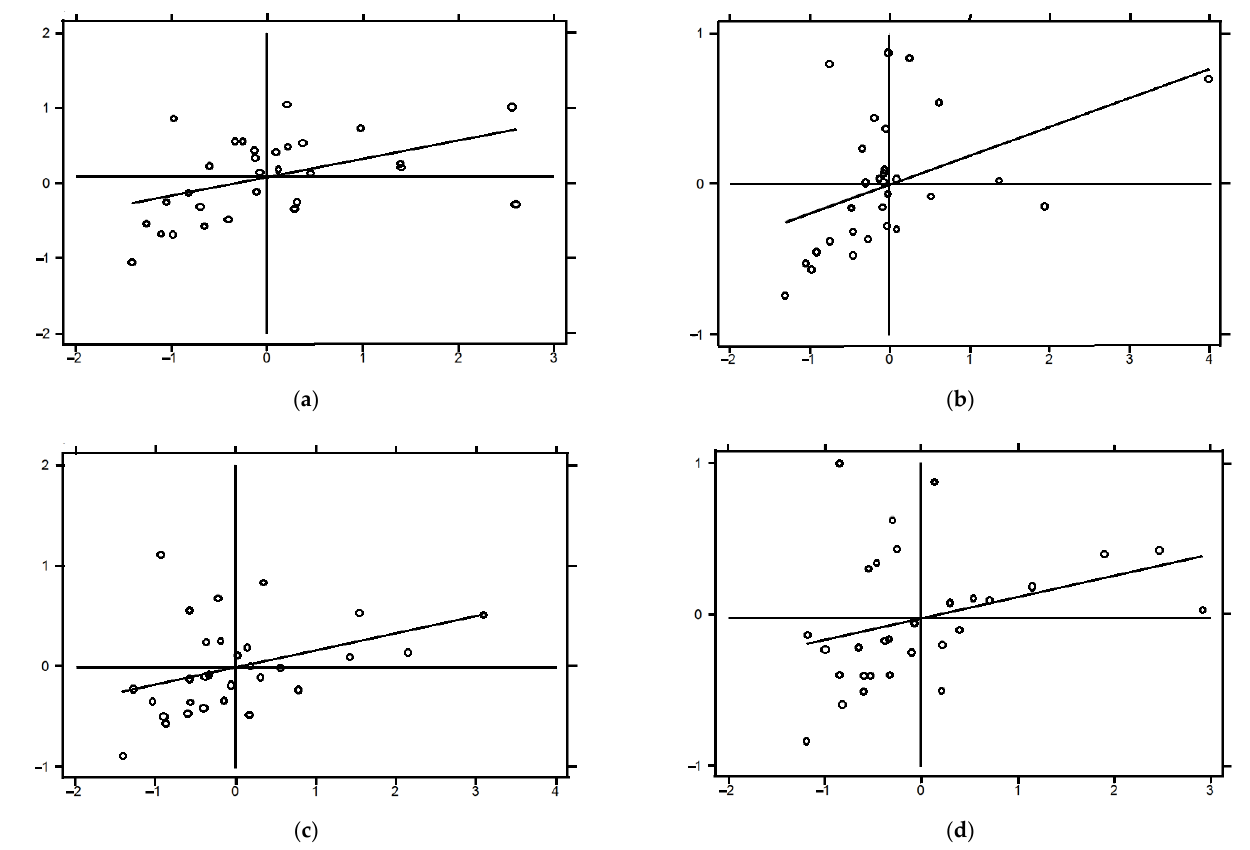
Figure 5. Moran scatters. ( a ) Local Moran’s I in 2006. ( b ) Local Moran’s I in 2010. ( c ) Local Moran’s I in 2014. ( d ) Local Moran’s I in 2018.